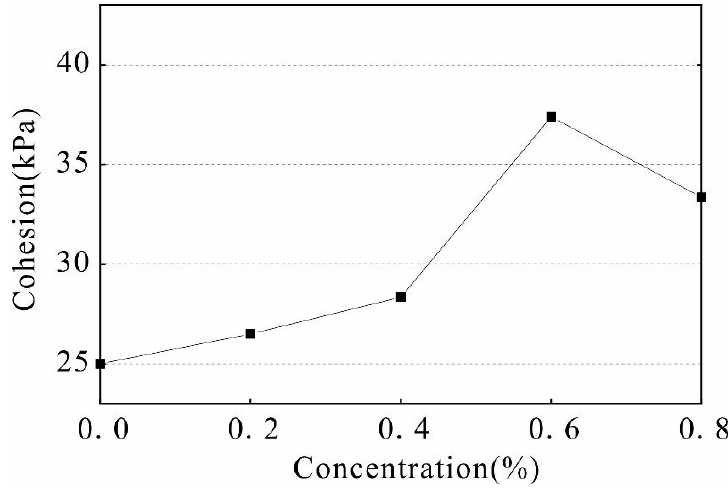
Figure 11. Cohesion curve under different stabilizer concentrations.